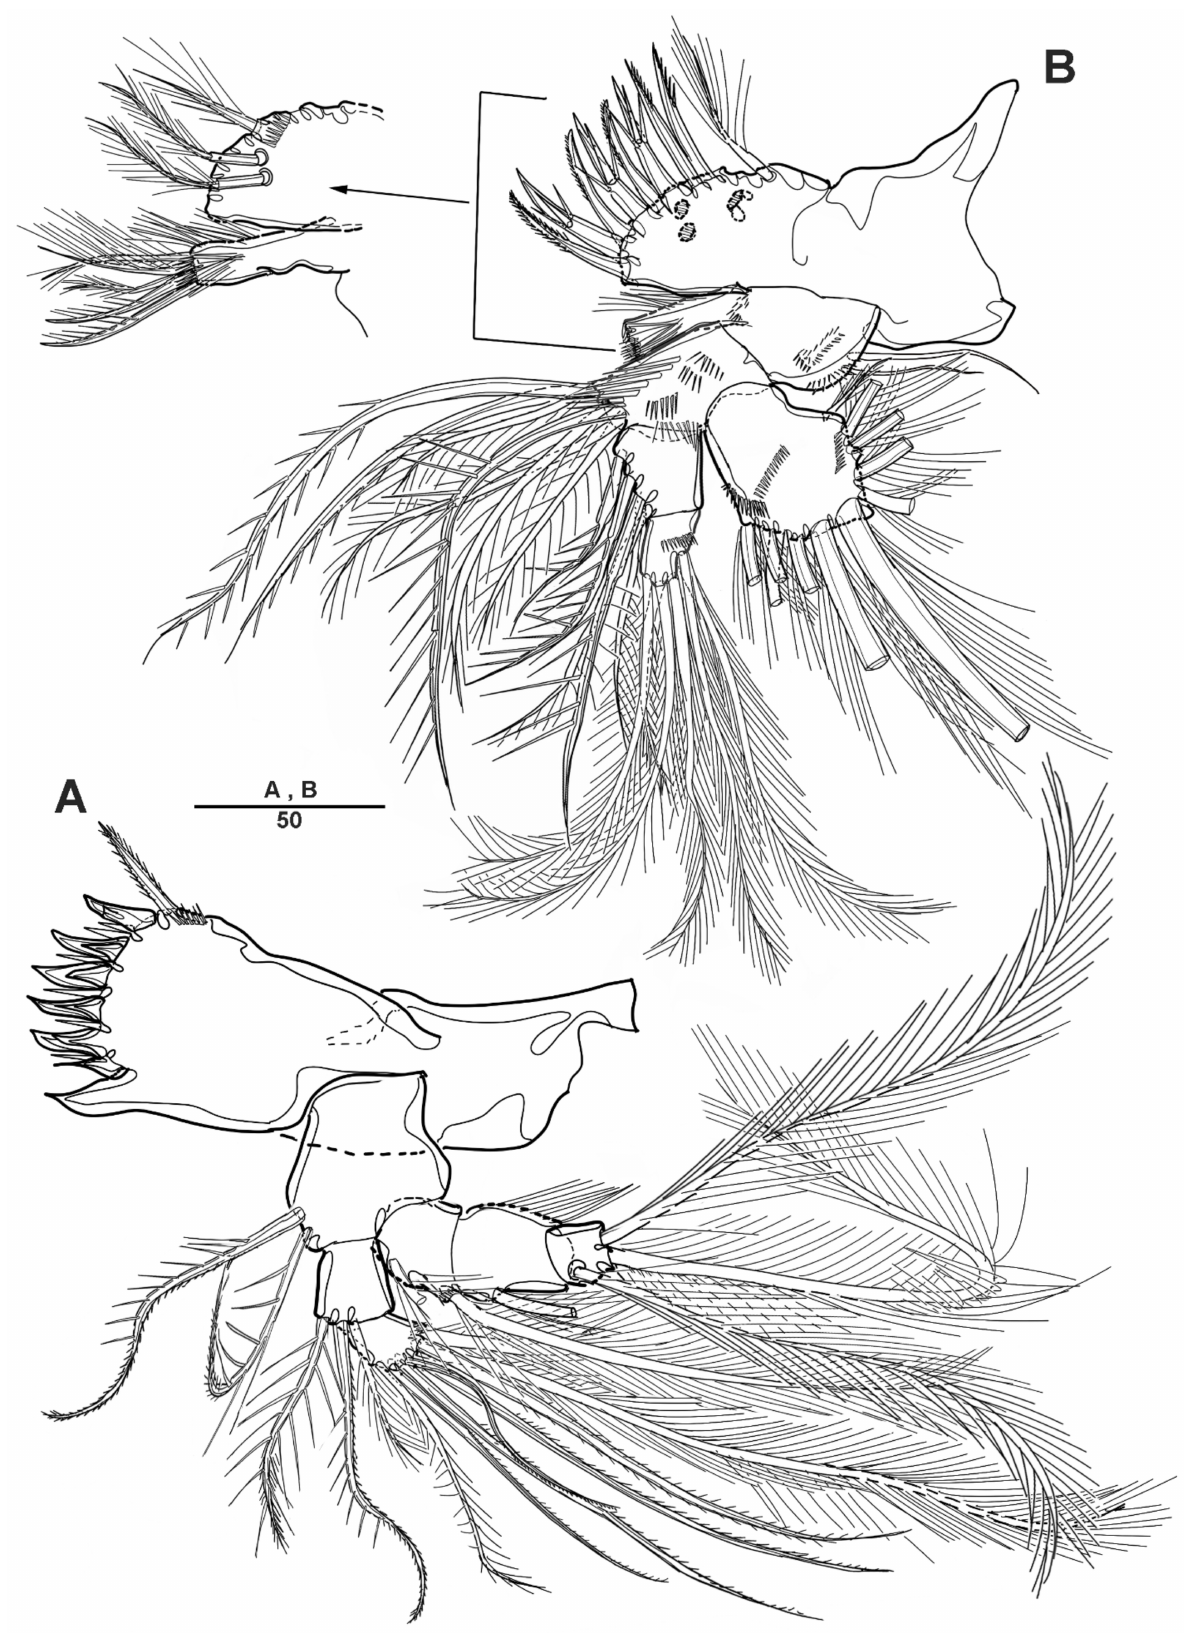
Figure 4. Scottolana daecheonensis sp. nov. holotype female: ( A ) mandible; ( B ) maxillule. Scale bars in µ